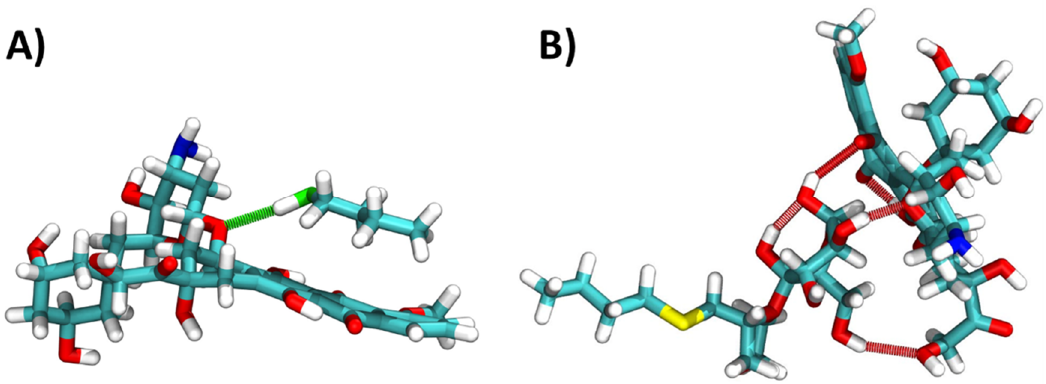
Figure 3. Final conformation of the complex formed between ( A ) the -SH functionalized fragments and ( B ) the glucose functionalized fragment and Dox. The hydrogen bonds formed between the molecules are depicted as a green dotted line in ( A ) and red dotted lines in ( B ).